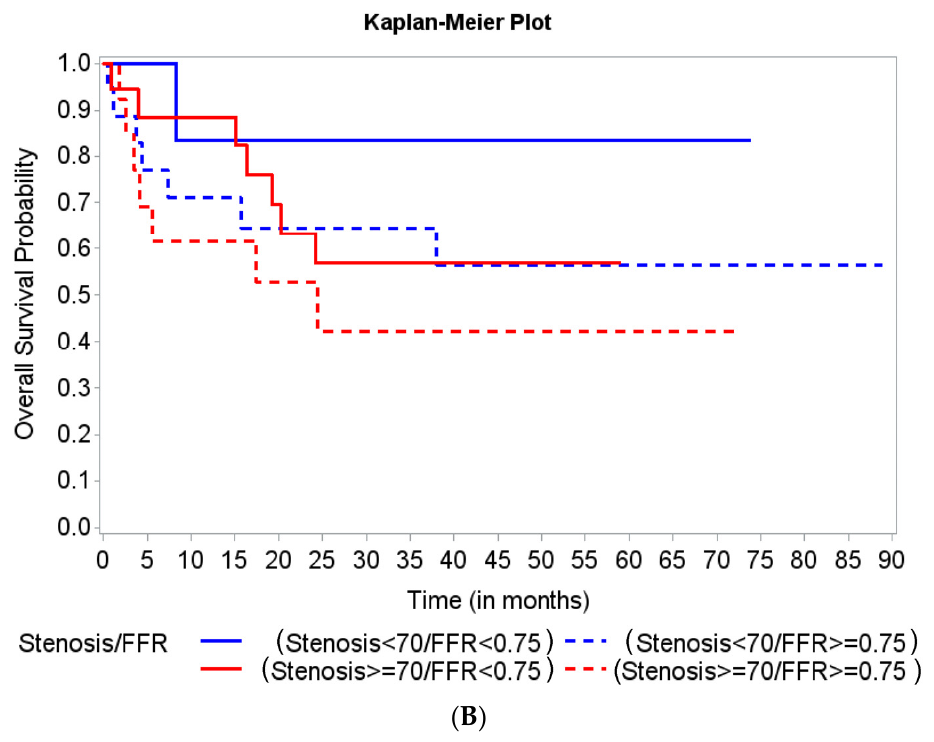
Figure 2. Kaplan Meier curves for overall survival based on stent implantation and lesion severity assessed by fractional flow reserve (FFR) and quantitative coronary angiography (QCA). ( A ) Patients who received a stent (a decision guided by FFR assessment) showed a significant association with a decreased risk of all-cause death. ( B ) The overall survival did not show any significant differences among the 4 groups of patients, based on the lesion severity assessment type.